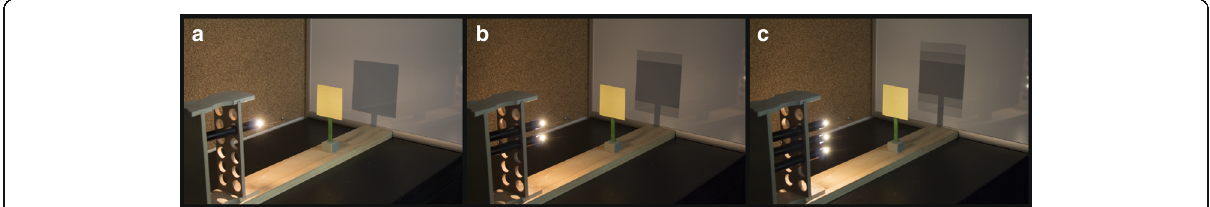
Fig. 2 Second stage of light experiment. Observation using pedagogical tools: one Mini-Maglite ™ ( a ), two Mini-Maglites ™ ( b ), and three Mini-Maglites ™ ( c